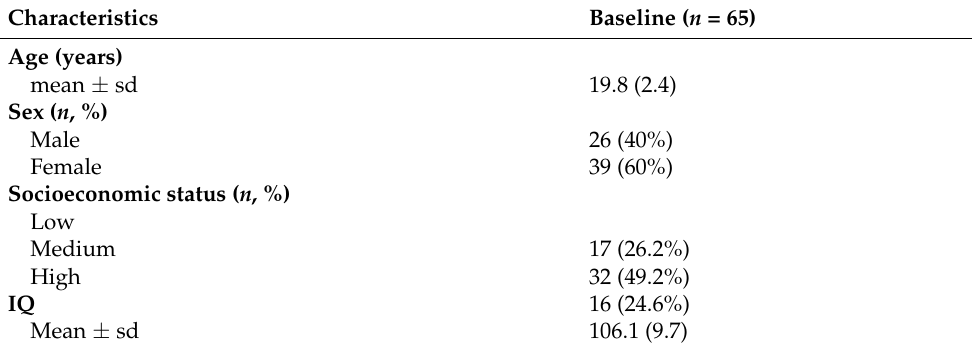
Table 1. Sociodemographic characteristics of PHIME participants included in this study at baseline and follow-up ( n =